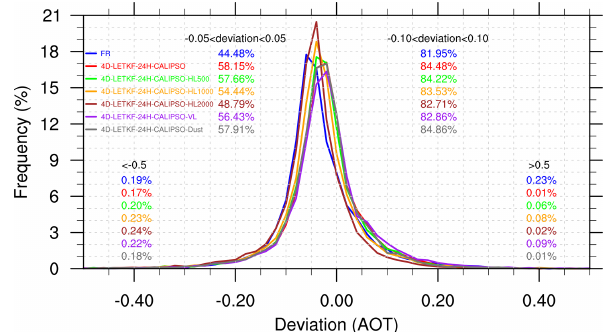
Figure 16. Frequency distributions of deviations (the simulated AOTs minus the observed AOTs) from the Moderate